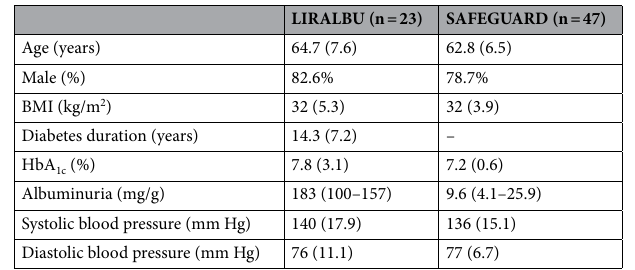
Table 1. Clinical characteristics at baseline. Data are presented as %, mean (SD) or median (IQR).